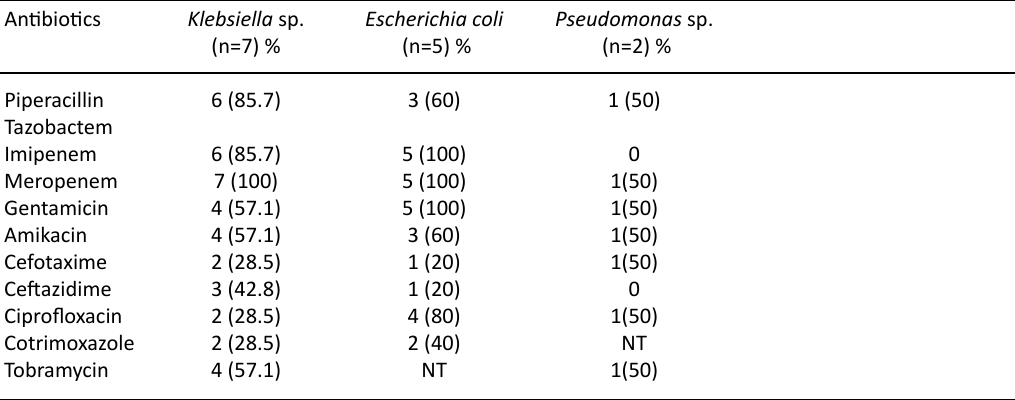
Table 4. Percentage of sensitivity of Gram negative isolates to various antibiotics Antibiotics Klebsiella sp. Escherichia coli Pseudomonas sp.